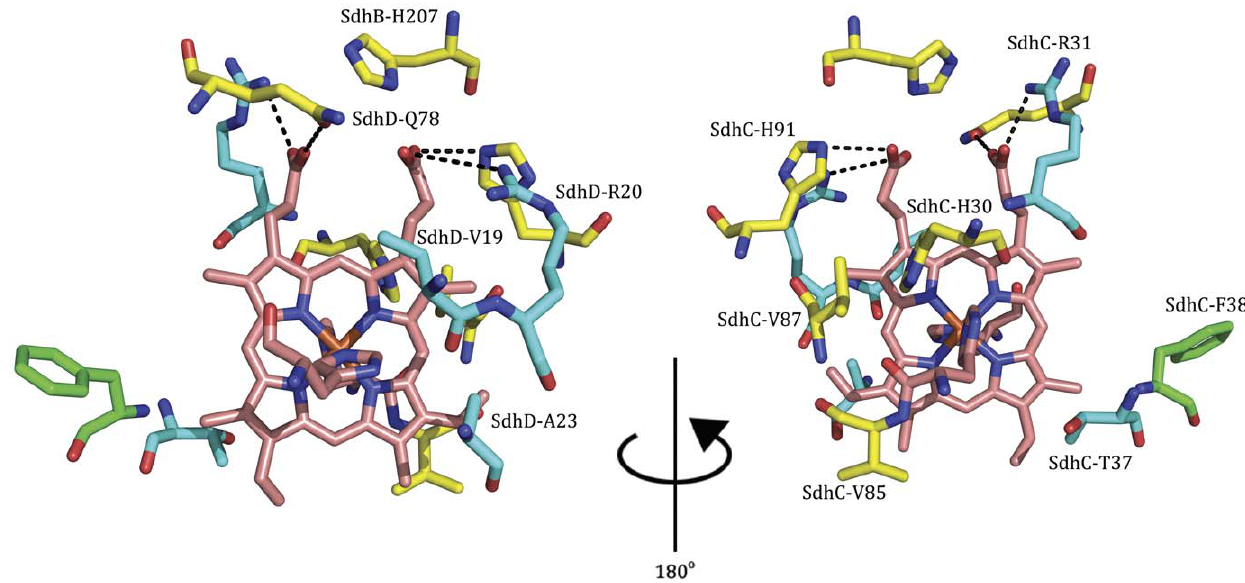
Figure 1. Residues selected for mutation. Upon mutation, residues that result in a shift towards the ‘‘sharp’’ EPR spectrum are colored in yellow while positions causing a shift towards the ‘‘broad’’ EPR spectrum are colored in blue. Residues that did not affect the EPR spectrum when mutated are shown in green. (pdb: 1NEK [4]).